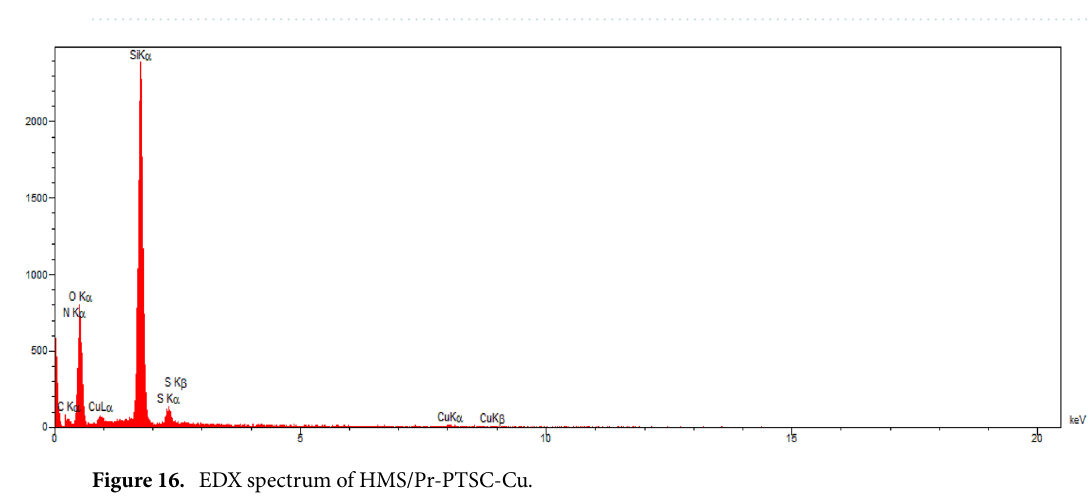
Figure 16. EDX spectrum of